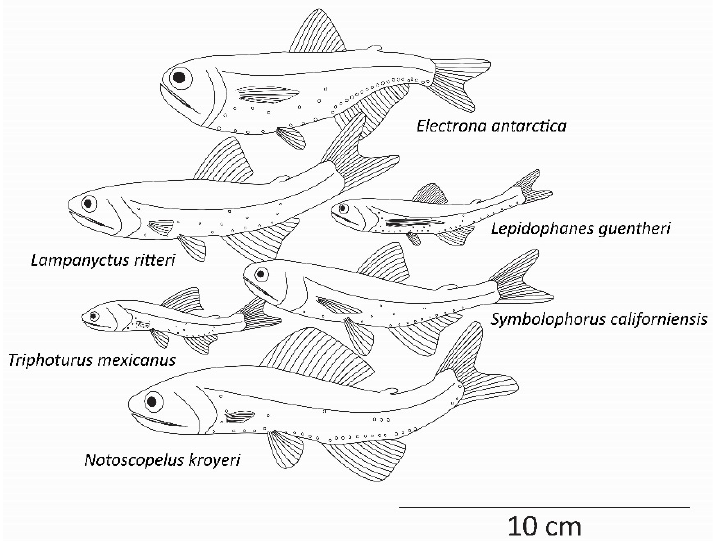
Figure 1. Lanternfishes of the family Myctophidae (order Myctophiformes).